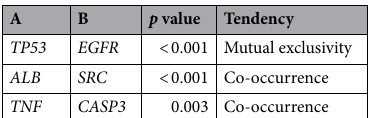
Table 2. Mutual exclusivity analysis, as performed using